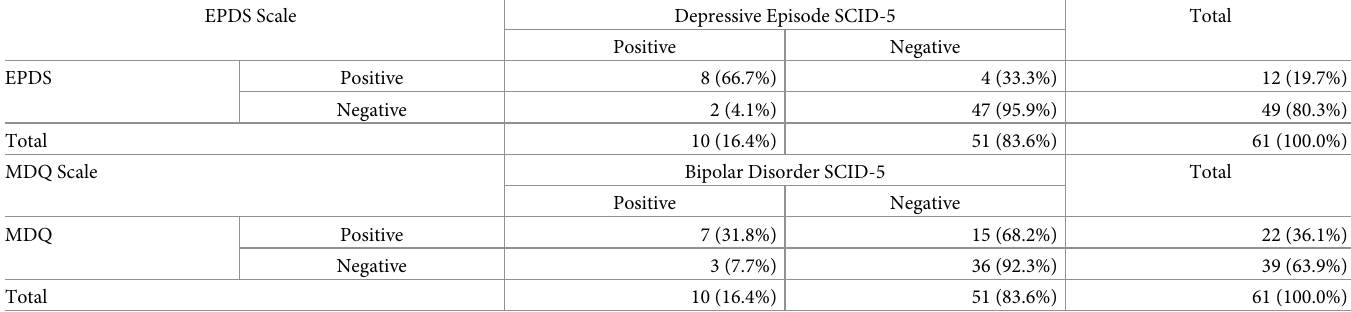
Table 3. Accuracy of Edinburgh Postpartum Depression Scales and Mental Disorder Questionnaire for the identification of depressive episode and bipolar disorder. EPDS